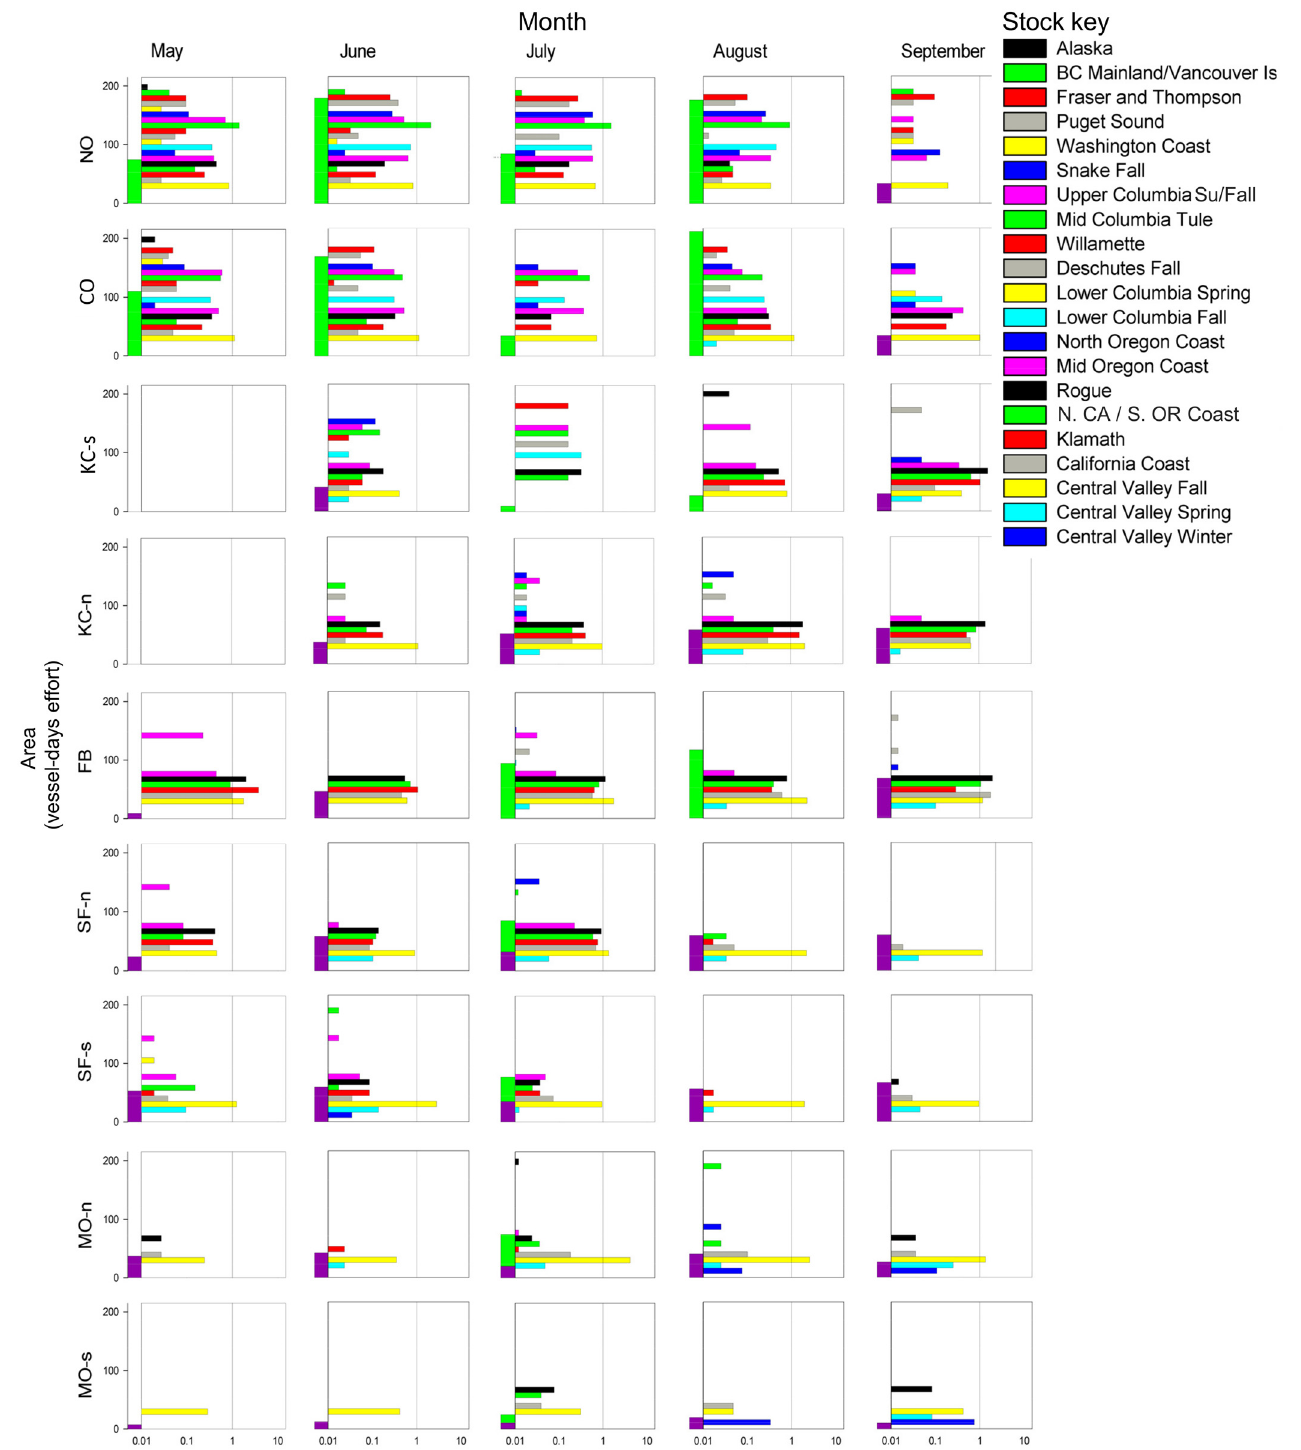
Fig 4. Log stock-specific catch per vessel day of fishing effort. Stock-specific catch per unit effort was sampled for 22 stocks encountered in nine area strata sampled May — September, 2010. Vertical green (retention) and magenta (non-retention) bars on left axis shows effort in total days fished. Stocks are listed by north to south order of natal rivers. Sample area abbreviations (also see Fig 1): North Oregon Coast, NO; Central Oregon Coast, CO; Oregon Klamath Zone, KO; California Klamath Zone north, KC-n; Fort Bragg, FB; San Francisco north, SF-n; San Francisco south, SF-s; Monterey Bay north MO-n; and Monterey Bay south, MO-s. Sampling was not conducted during the month of May in areas KO and KC-n.